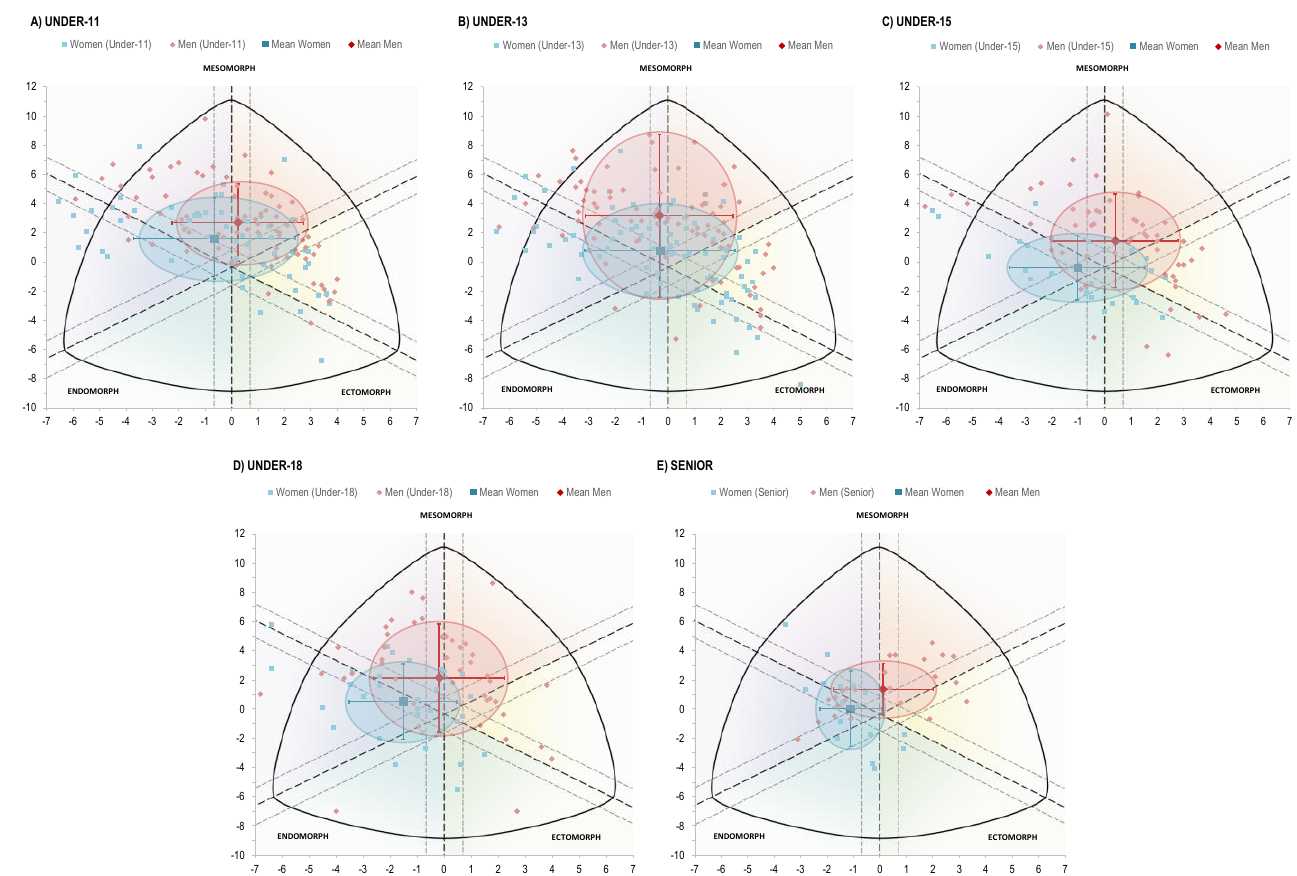
Figure 1. Somatotype distribution of high-level table tennis players according to sex and age categories. Clear markers indicate individual data for each player. Dark markers represent the mean values for a given category. Error bars are standard deviations.